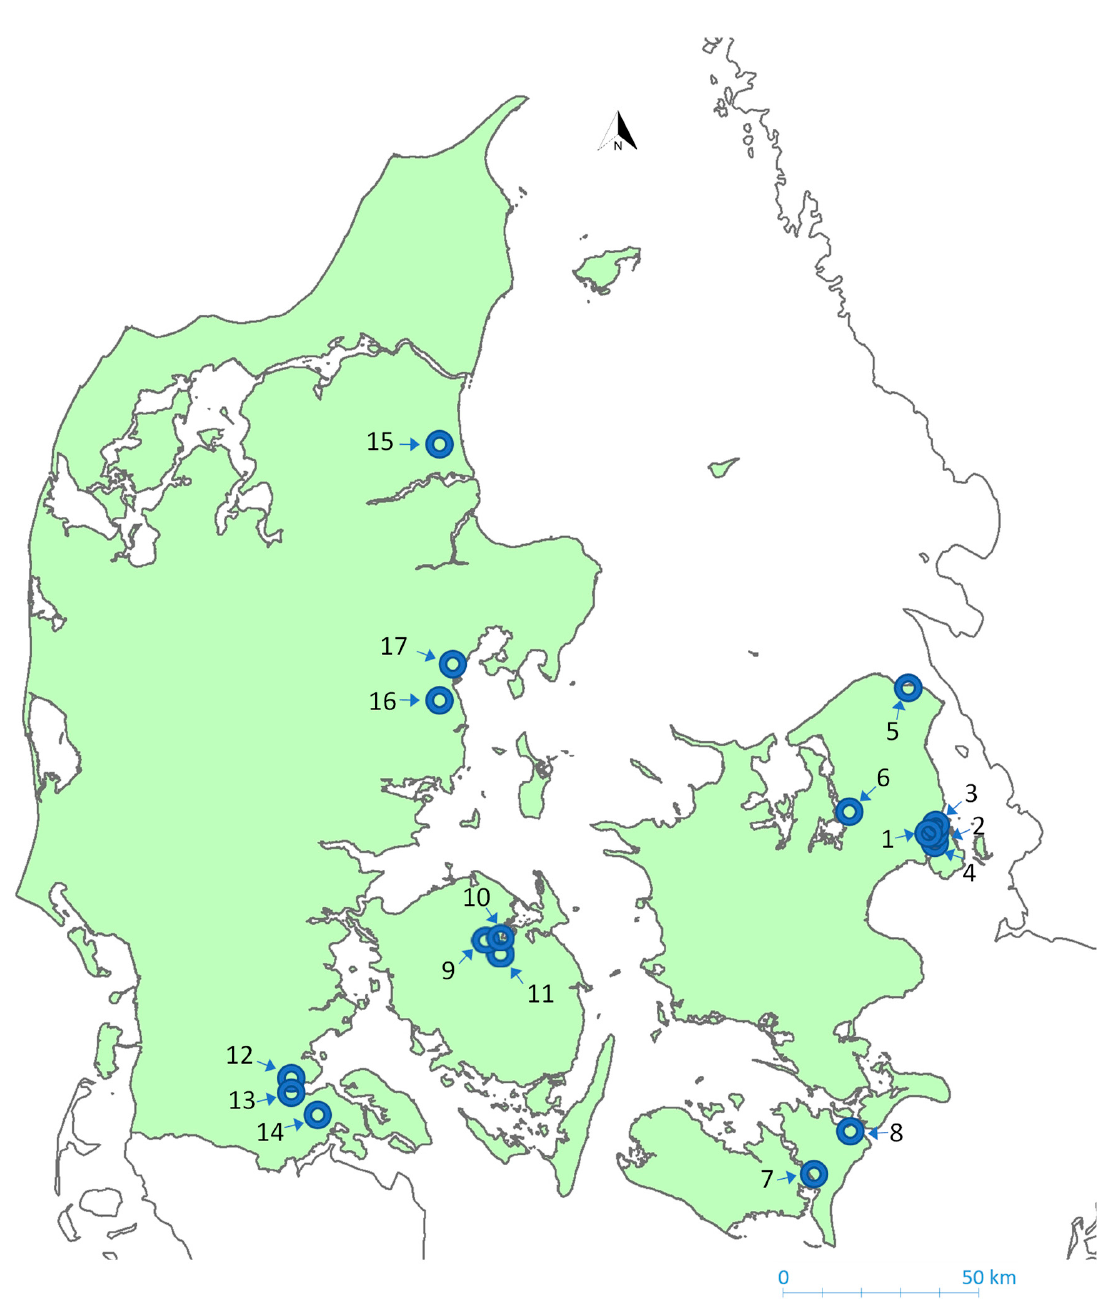
Figure 1. Map of the 17 sites in Denmark selected for sampling and analysis of MP in Danish drinking water.